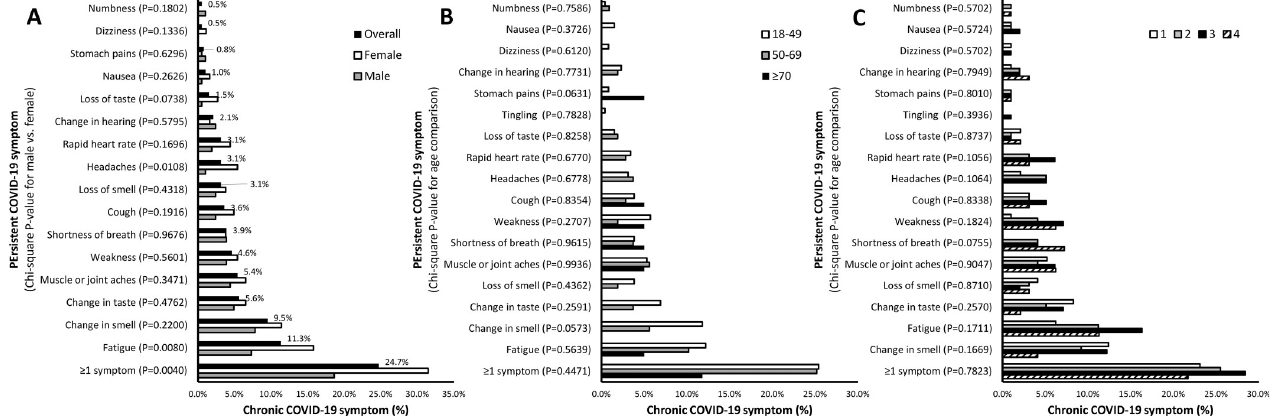
Fig 2. Chronic COVID-19 symptoms. Proportions of chronic COVID-19 symptoms were determined overall (A) and stratified by (A) sex, (B) age and (C) level of SARS-CoV-2 IgG antibody levels. Chi-square tests were performed comparing the frequency of chronic COVID-19 symptoms by sex, age and level of SARS-CoV-2 IgG antibody levels. P-values are presented in the graphs.